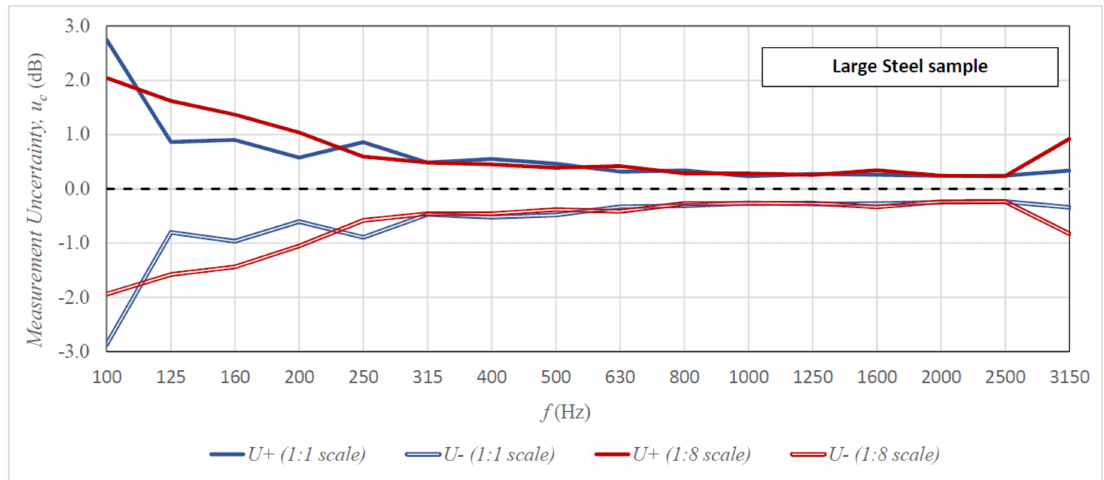
Figure 8. Uncertainty of sound insulation measurement for the 1 × 2 m steel plate specimen (1:1 scale stand)/125 × 250 mm (1:8 scale stand) as a function of frequency for the 10-element measurement samples; the results from the scaled rooms were scaled to actual measurement frequencies. Table 1. Uncertainty of sound insulation measurement for all tested specimens for the 10-element measurement samples vs. the ISO 12999-1 recommendations [26]; the results from the scaled rooms were scaled to actual measurement frequencies. ISO 12999-1 f (Hz)